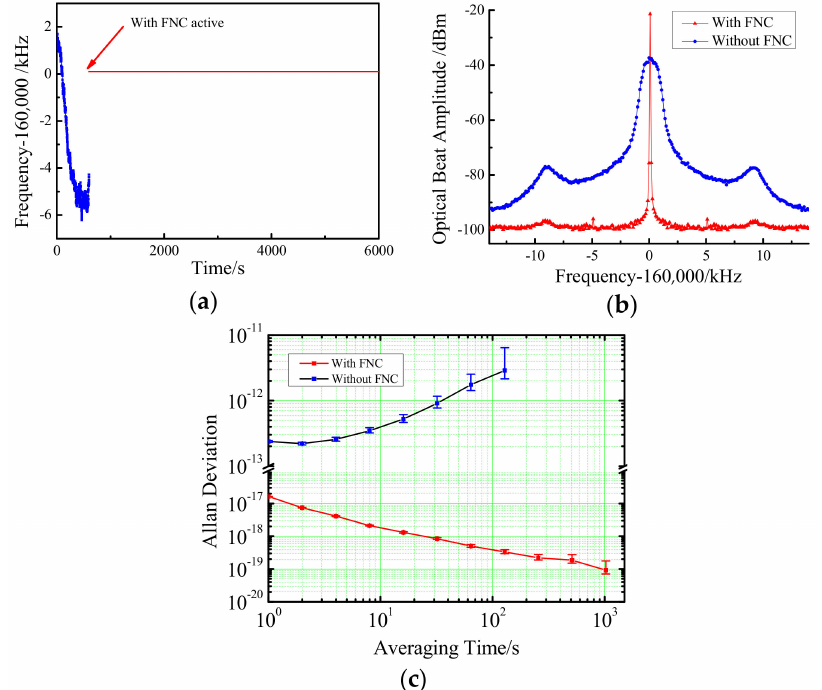
Figure 2. ( a ) Frequency fluctuation of the beat signal with and without the FNC system; ( b ) Optical field spectrum of the beat signal with and without the FNC system; ( c ) In loop frequency stability (Allan deviation) of the FNC system. The data sample has a 1-s gate